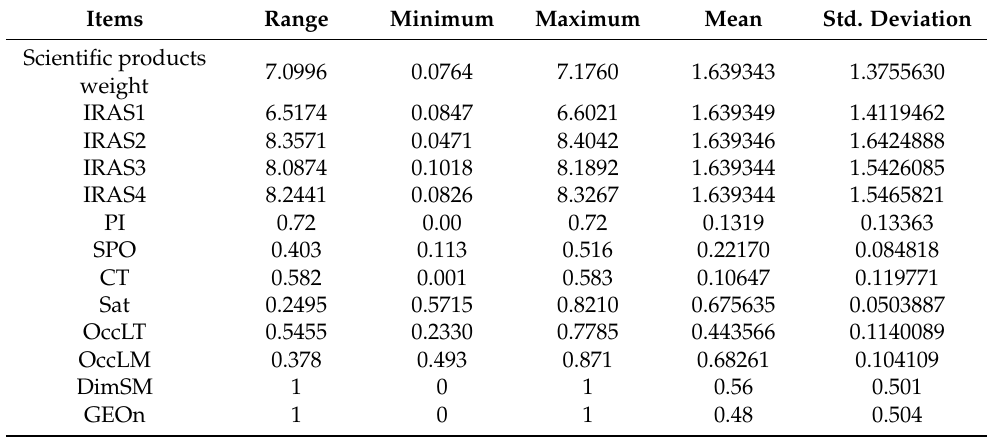
Table 2. Descriptive